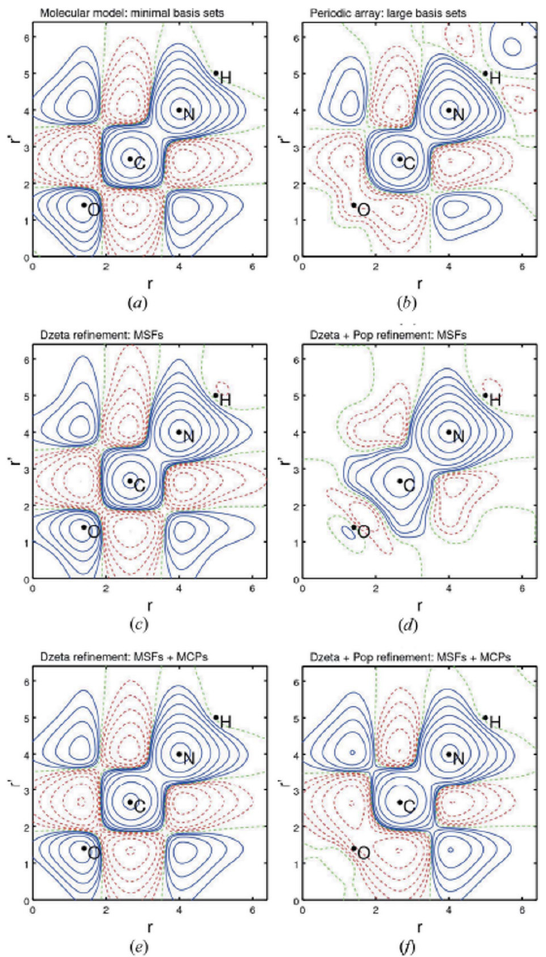
Figure 4. The spin-resolved 1-RDM of the urea molecule is plotted along the O-C-N-H direction (above the plane of the molecule by 0.5 Å). The upper panel shows the ( a ) molecular and ( b ) periodic computation of the spin-resolved 1-RDM. The second panel shows the spin-resolved 1-RDM ( c ) after a Dzeta refinement (i.e., refinement of the Gaussian exponents only) and ( d ) after a Dzeta + Pop refinement (i.e., refinement of the Gaussian exponents and of the spin population matrix) relative to the magnetic structure factors only (MSFs). The lower panel ( e , f ) is analogous to the second one, but it refers to the joint refinement against magnetic structure factors and magnetic Compton profiles (MSFs + MCPs). Contours at intervals of ± 0.01 × 2 n a.u. − 3 ( n = 0–20 ) : positive and negative contours are blue solid lines and red dashed lines, respectively; neutral contours are green dashed lines. Reproduced with permission of the International Union of Crystallography from reference